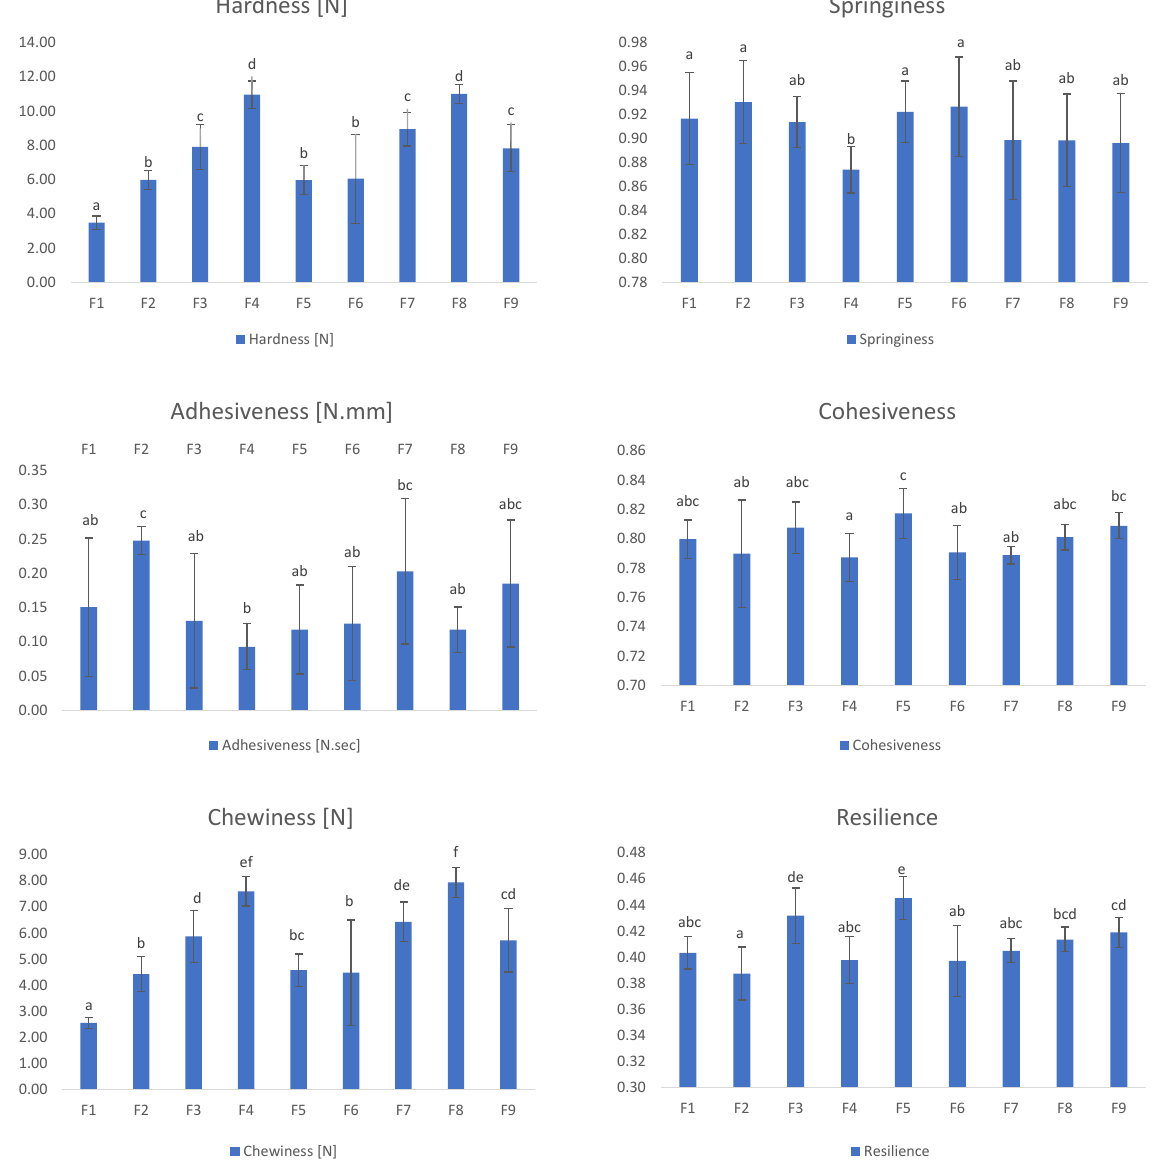
Figure 3. Texture Profile Analyses (TPA) of the 9 hybrid sausages used in the experiments. The samples, labelled from F1 to F9, contain different percentages of broccoli, upcycled brewer’s spent grain and insect flour (BR, BSG, IF): F1 (35, 0, 0), F2 (30, 5, 0), F3 (25, 0, 10), F4 (20, 5, 10), F5 (30, 0, 5), F6 (32, 3, 0), F7 (25, 5, 5), F8 (22, 3, 10) and F9 (27, 3, 5). Different letters in the same bar are significantly different according to Tukey’s test ( p < 0.05).